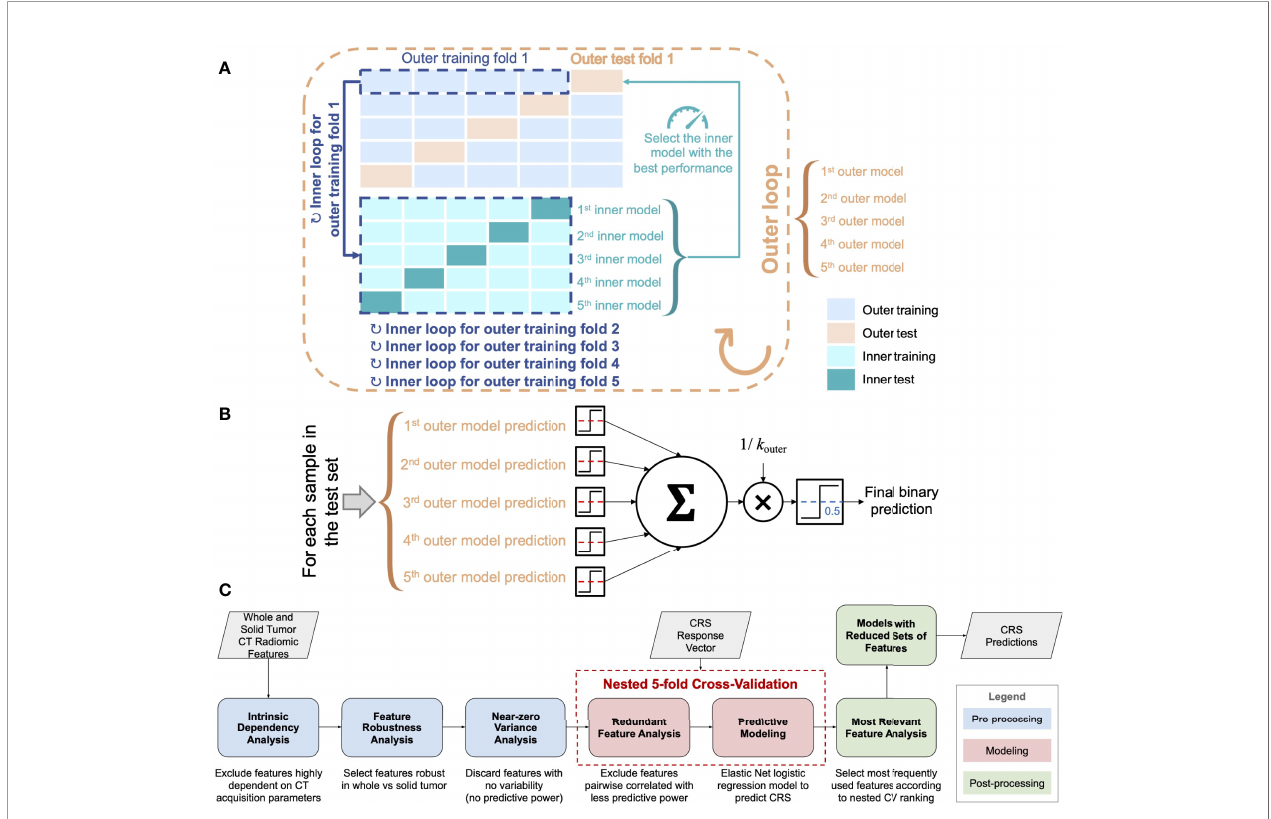
FIGURE 2 | (A) Scheme of the nested k -fold cross-validation (for k outer = 5 and k inner = 5). The nested fi tting procedure was repeated 100 times with different random permutations of the discovery dataset. (B) Majority voting for the ensemble of classi fi ers used for testing on the external test cohort (the dashed red lines denote the decision thresholds optimized according to the inner CV loop). (C) Work fl ow of the radiomics pipeline for CRS